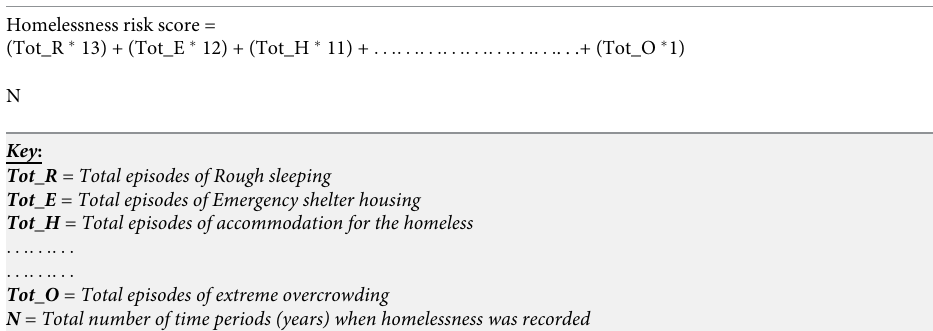
Table 1. Calculation of homelessness risk